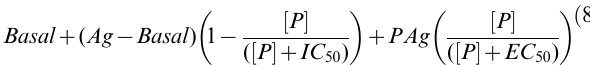
Figure S1 3 H-inositol phosphate accumulation in cells expressing the wildtype b 1-adrenoceptor and poly-